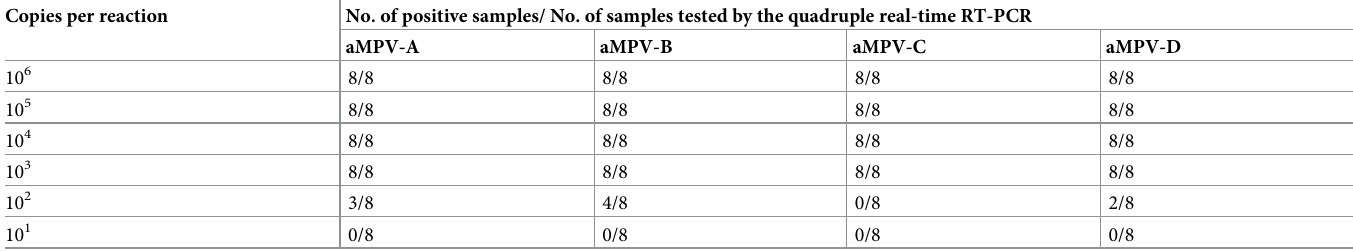
Table 3. Assay data used for probit analysis to calculate the detection limits of aMPV-A, aMPV-B, aMPV-C and aMPV-D. Copies per reaction